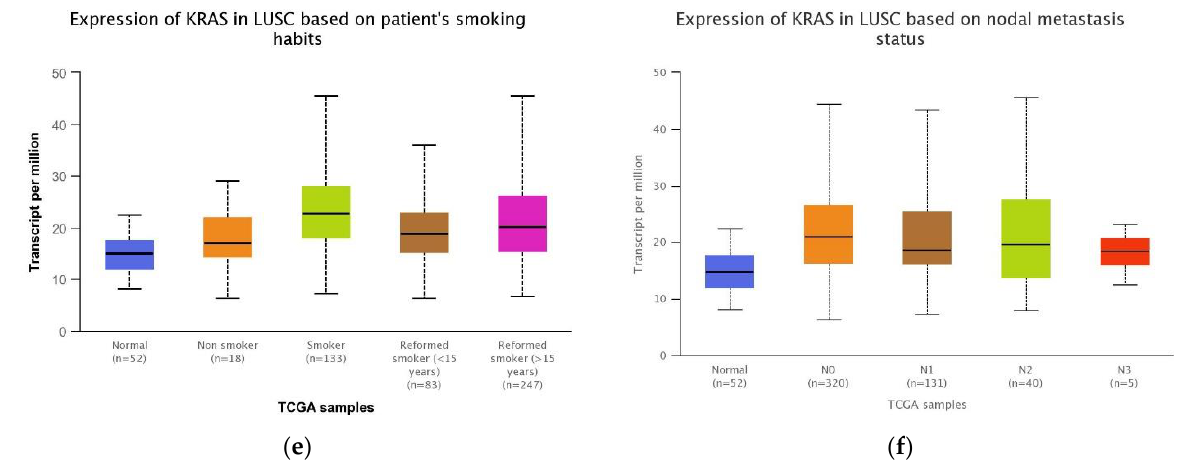
Figure 4. KRAS expression profile in lung squamous cell carcinoma. Box-whisker plots showing the expression of KRAS in normal and tumor samples ( a ), tumor subgroups based on individual cancer stages ( b ), patient sex ( c ), age ( d ), smoking status ( e ), nodal metastasis ( f ). (Data derived from the UALCAN server (http://ualcan.path.uab.edu/ (accessed on 15 June 2022))).